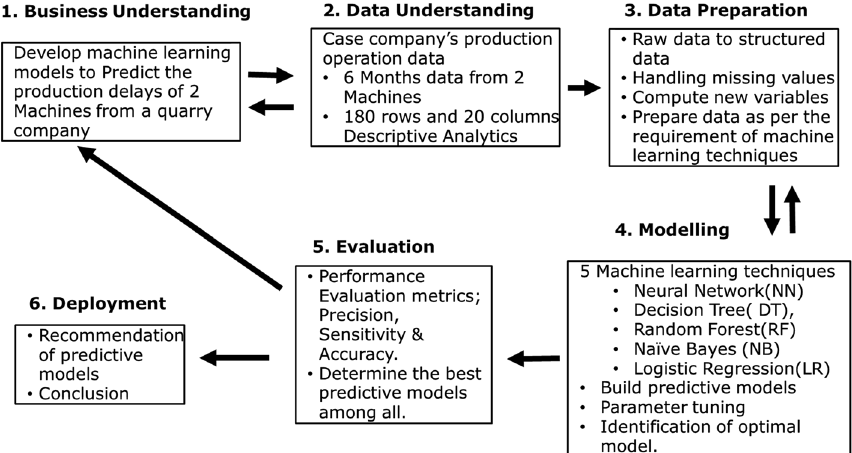
Fig. 1 Research methodology based on